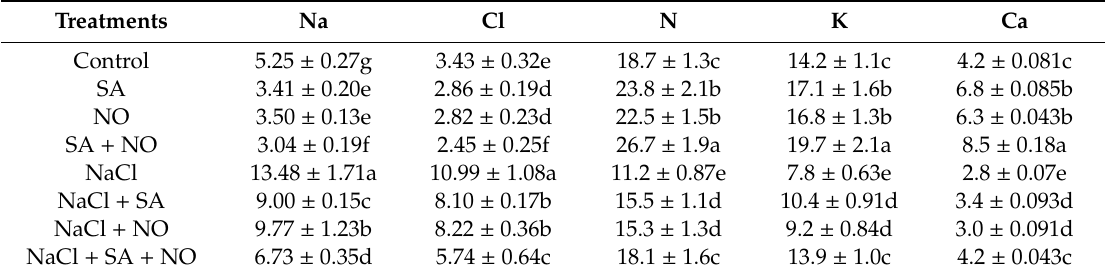
Figure 6. E ff ect of exogenous application of SA and NO on ( A ) ascorbic acid, ( B ) reduced glutathione and ( C ) tocopherol content in Vigna angularis under salinity (100 mM NaCl) stress. Data are the mean of four replicates and di ff erent letters show significant di ff erence at p < 0.05. Table 3. E ff ect of exogenous application of SA and NO on uptake of Na, Cl, N, K, and Ca (mg g − 1 DW) in Vigna angularis under salinity (100 mM NaCl) stress. Data are the mean of four replicates and di ff erent letters show a significant di ff erence at p <